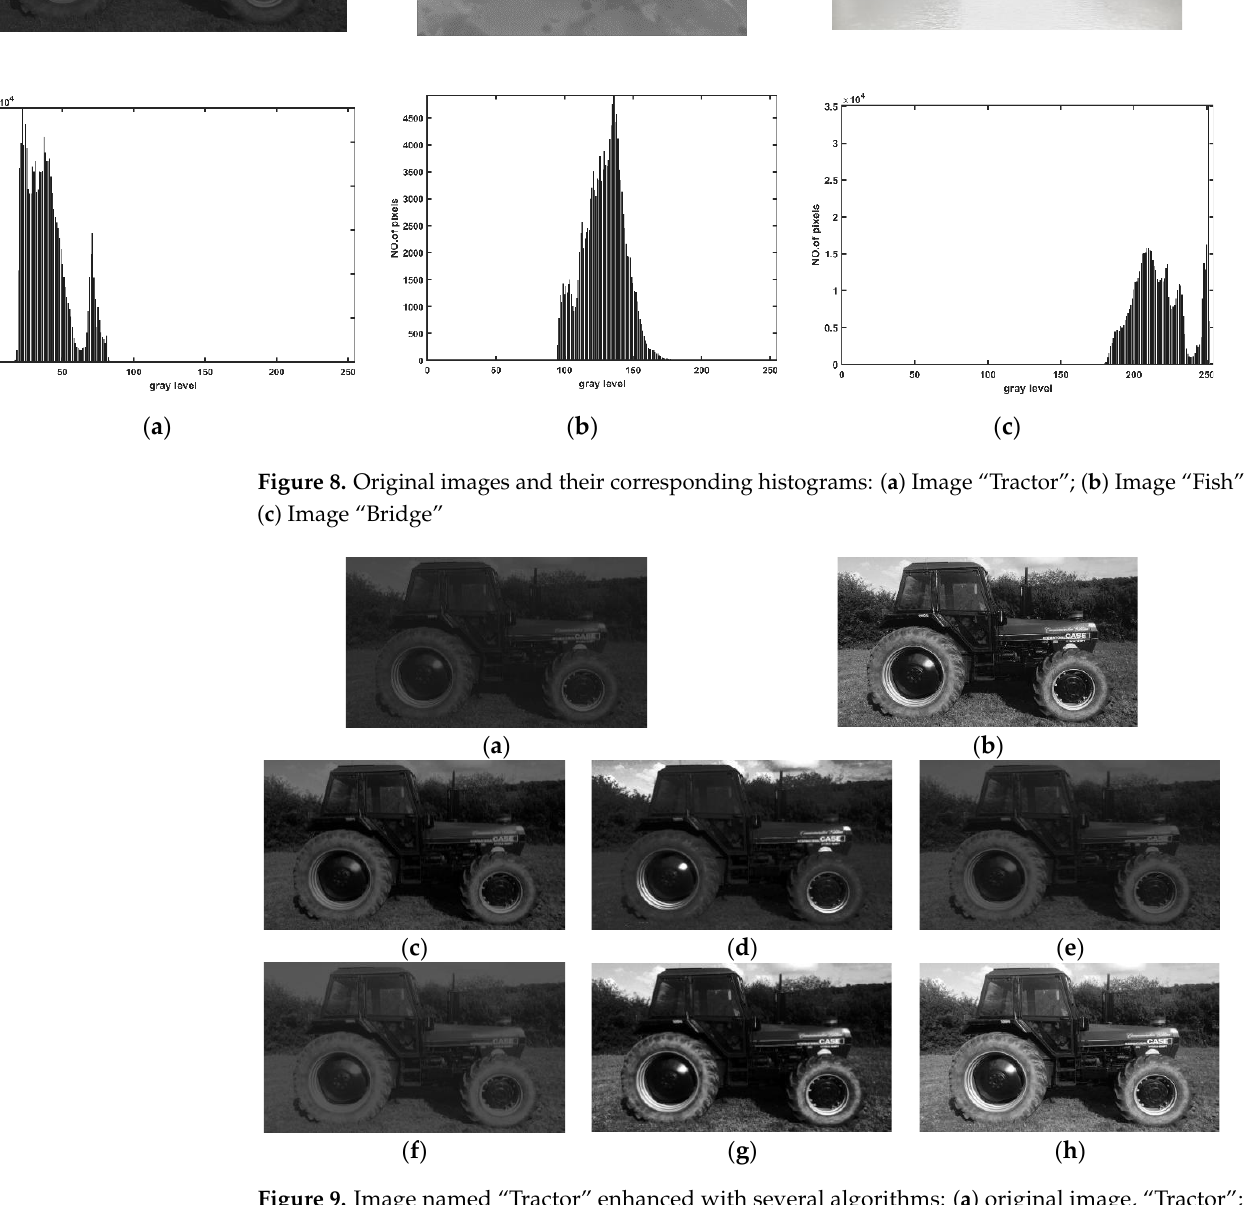
Figure 9. Image named “ Tractor ” enhanced with several algorithms: ( a ) original image, “ Tractor ” ; ( b ) Ref. 30; ( c ) BHEMHE; ( d ) RMSHE; ( e ) DSIHE; ( f ) AGCWD; ( g ) BHEPL; ( h ) proposed method.